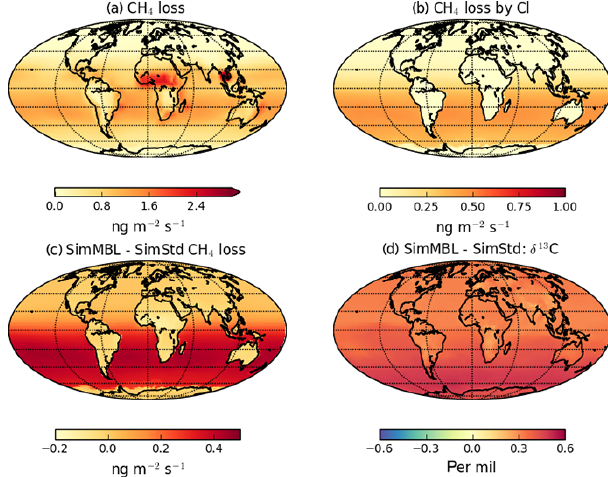
Figure 9. January (a) CH 4 loss and (b) CH 4 loss by Cl only in the SimMBL simulation, as well as the difference in (c) CH 4 loss and (d) δ 13 C-CH 4 between the SimMBL and SimStd simulations.